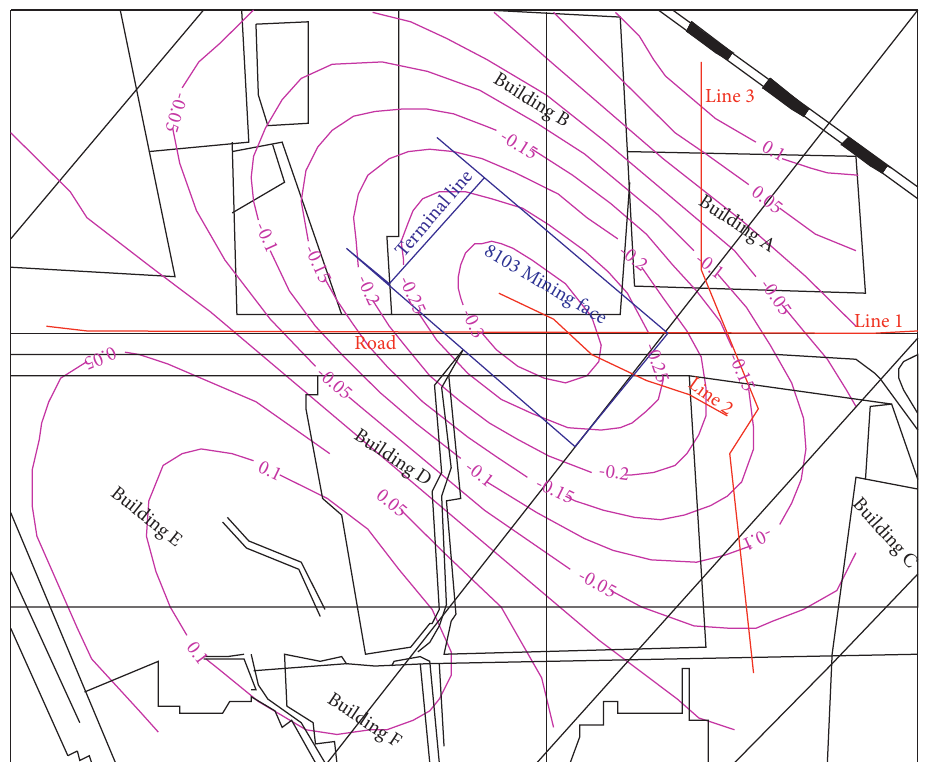
Figure 25: Forecast contour of surface horizontal deformation along inclination in 8103 backfilling